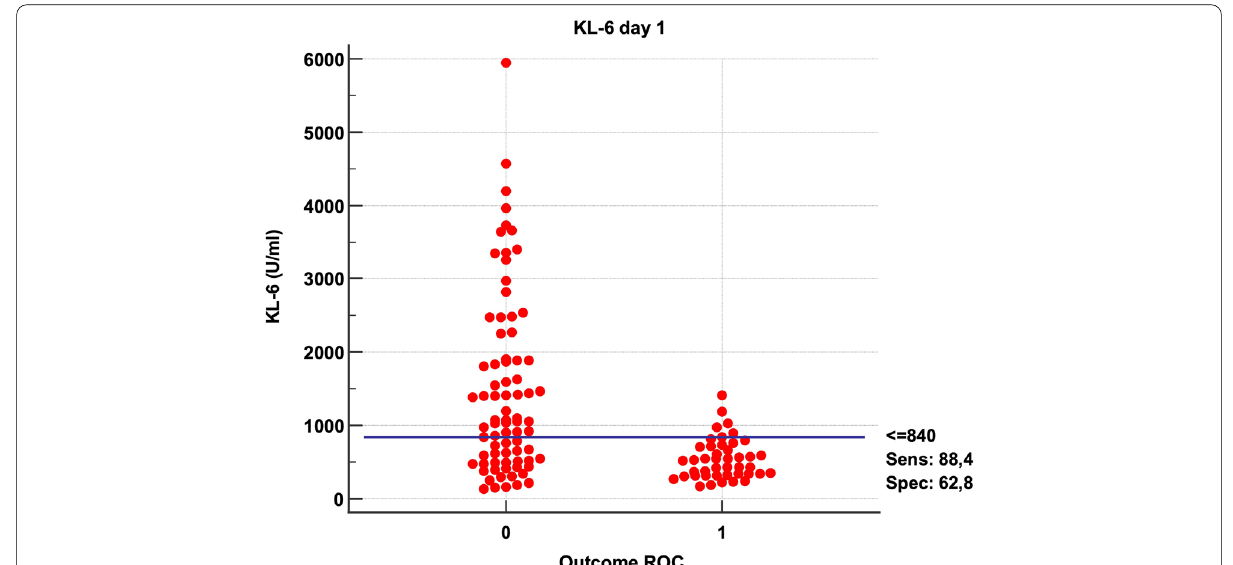
Fig. 1 Dot plot diagram comparing KL-6 values measured on admission comparing patient who survived (column 1) with patient who did not survive (column 0). If the cutoff 840 U/ml, KL-6 showed a sensibility of 88.4% and a specificity of =